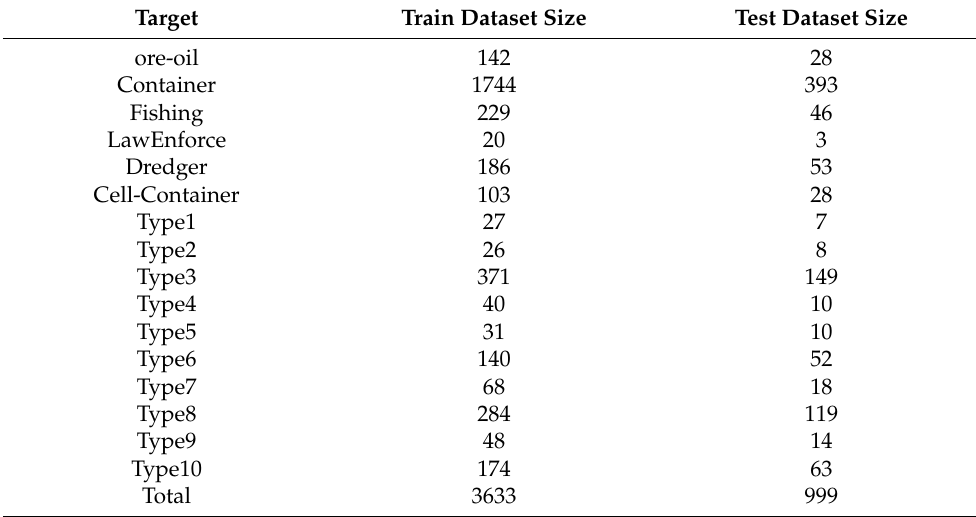
Table 1. Statistics of the number of vessels of each